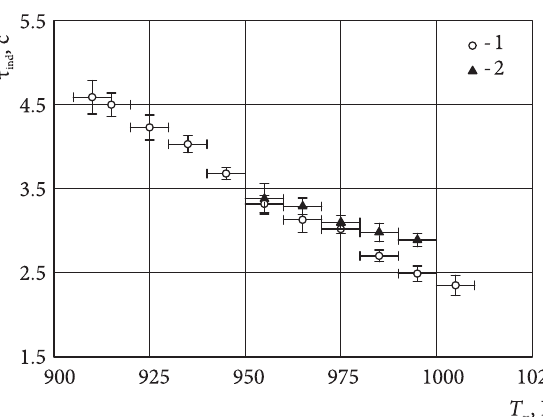
Fig. 5. Single droplet ignition delay time reliance on ambient temperature: 1 – diesel fuel (MD), 2 – two-component fuel